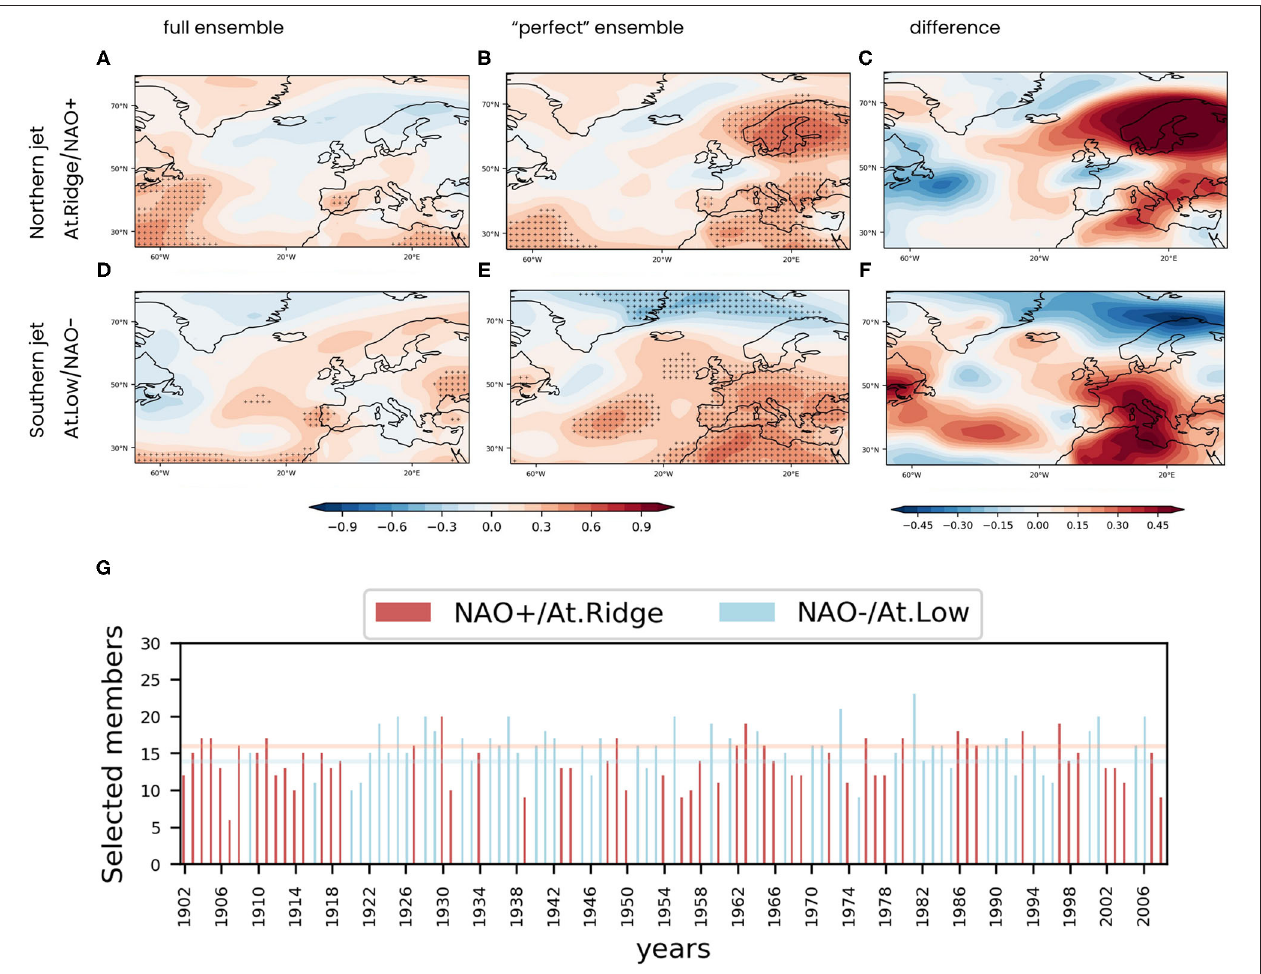
FIGURE 7 | “Perfect” model approach. ACC for SLP, comparing the test ensemble to the reanalysis in 1902–2008. On the upper row, ACCs are calculated for years where the observed dominant summer atmospheric teleconnection is classified as either At.Ridge or NAO + . Conversely, in the lower row, ACCs are calculated for At. Low or NAO − cases. ACCs are presented as follows: (A,D) the ensemble mean is taken over the full ensemble; (B,E) only members whose classification matches the observed are selected to calculate the ensemble mean; (C,F) differences in ACC between full and selected ensemble mean. Stippling represents correlation significant at the 95% level. (G) Bar plots show the fraction of ensemble members selected per year: red bars for observed At.Ridge or NAO + , blue bars for At. Low or NAO- cases. Horizontal lines show the mean fraction for each